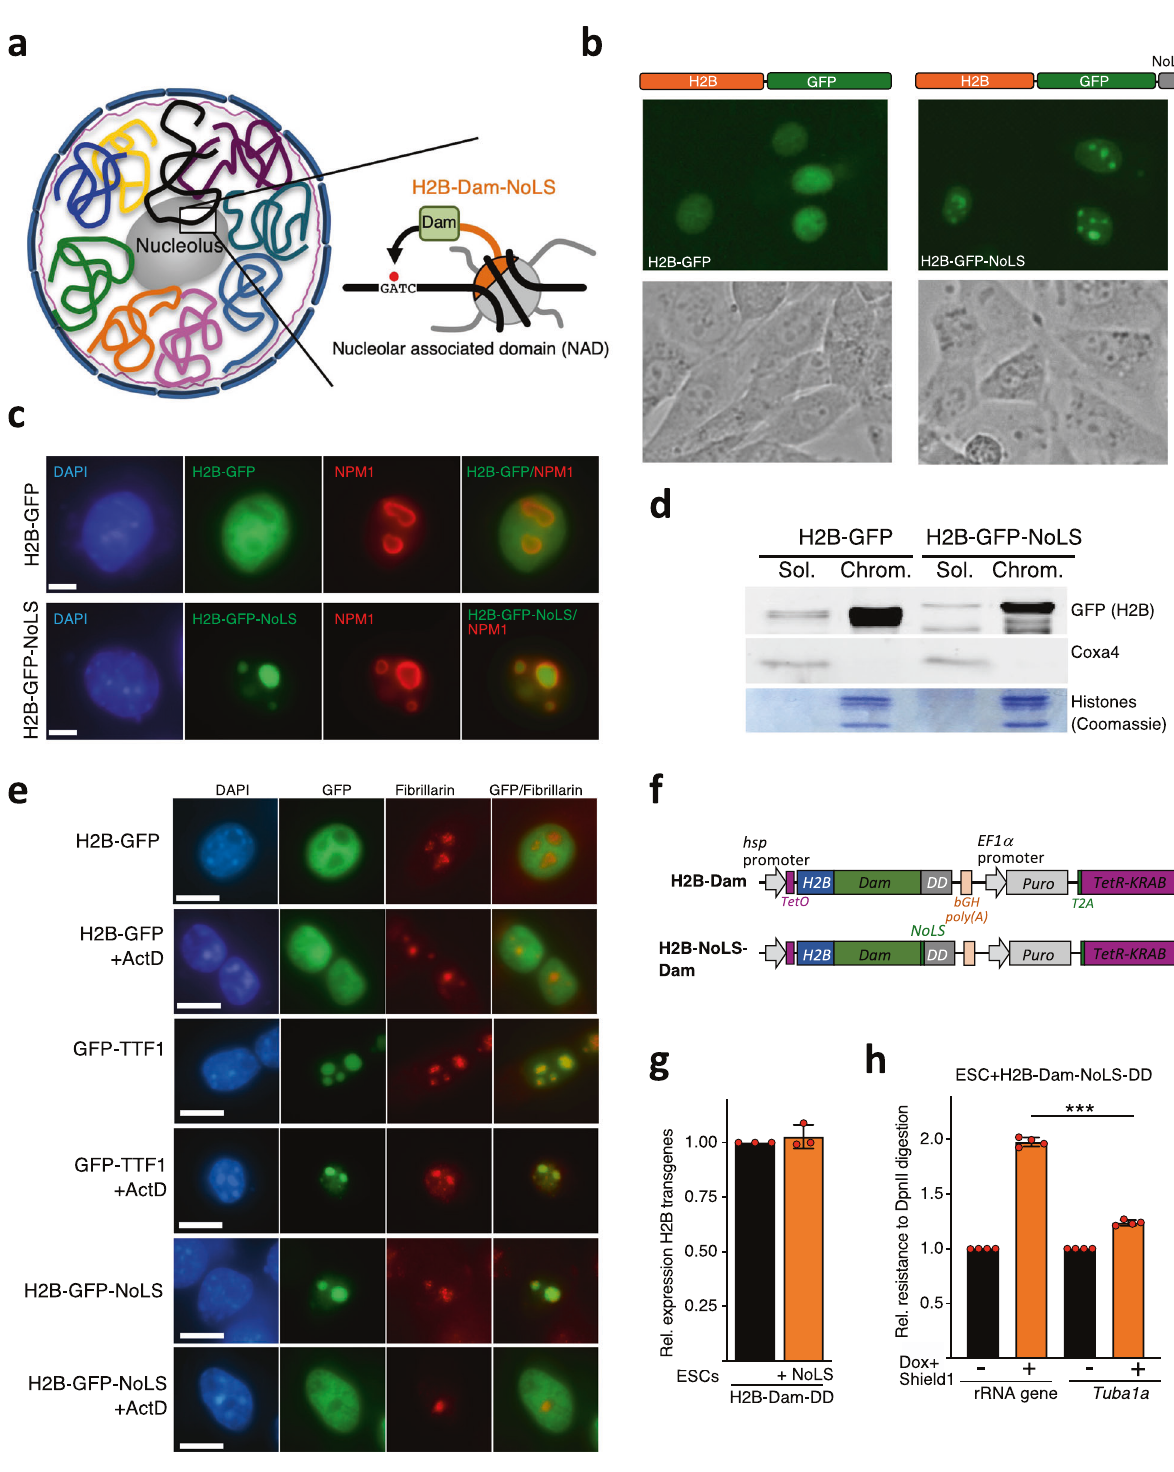
did not affect the localization of H2B-GFP whereas, as expected, Fibrillarin and ectopically expressed GFP-TTF1, which both associate with rRNA genes 29 , segregated into nucleolar caps (Fig. 1e). In contrast, upon ActD treatment, H2B-GFP-NoLS signal localized outside the nucleolus. These results indicated that the nucleolar localization of H2B-NoLS depends on nucleolus integrity. Furthermore, the data suggest that genomic regions that incorporated H2B-NoLS in the nucleolus redistributed outside of it upon nucleolar segregation.